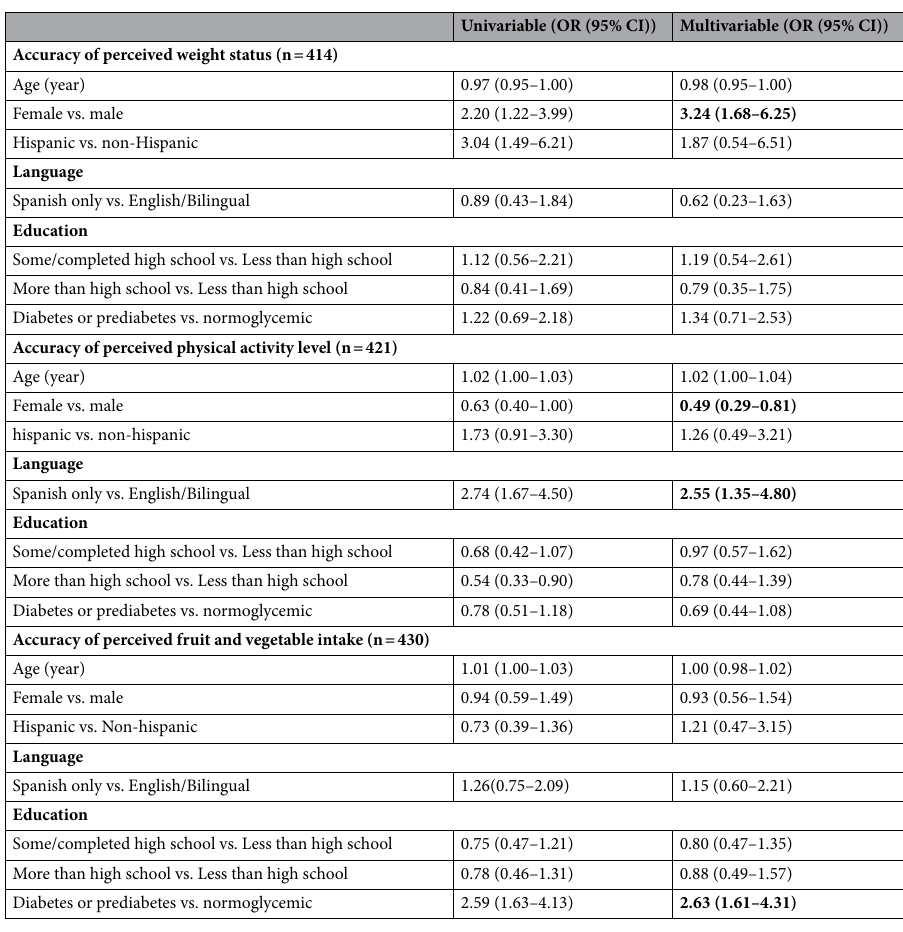
Table 5. Associations between patient characteristics and accuracy of perceptions at baseline. OR odds ratio, CI confidence interval. Bold numbers indicate p < 0.05.